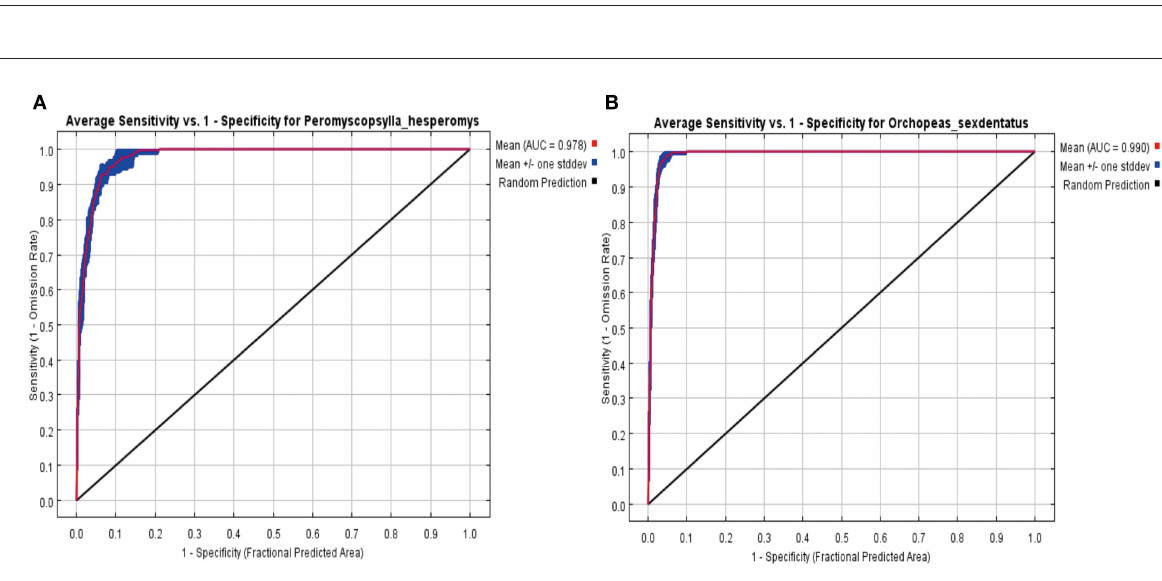
FIGURE9 Receiver operating characteristic (ROC) curve by the MaxEnt for P. hesperomys (A) and O. sexdentatus (B)